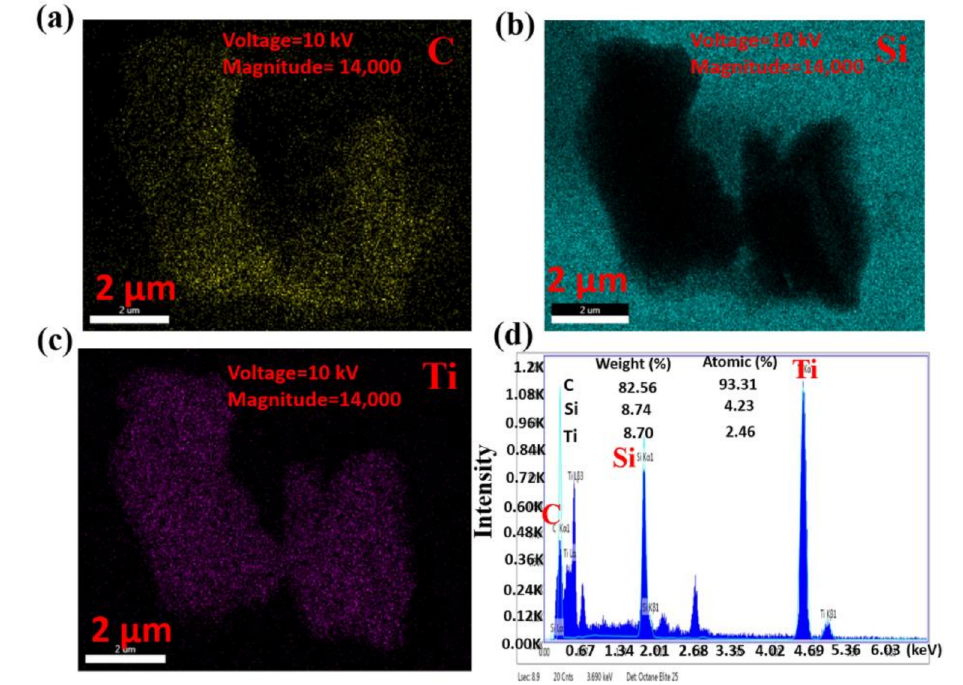
Figure 4. Elemental mapping and optical properties of the MXene–GO heterojunction: ( a ) carbon, ( b ) silica, and ( c ) titanium elemental analysis of the MXene–GO heterojunction; ( d ) element ratios of the MXene–GO heterojunction analyzed by energy dispersive spectroscopy (EDS).